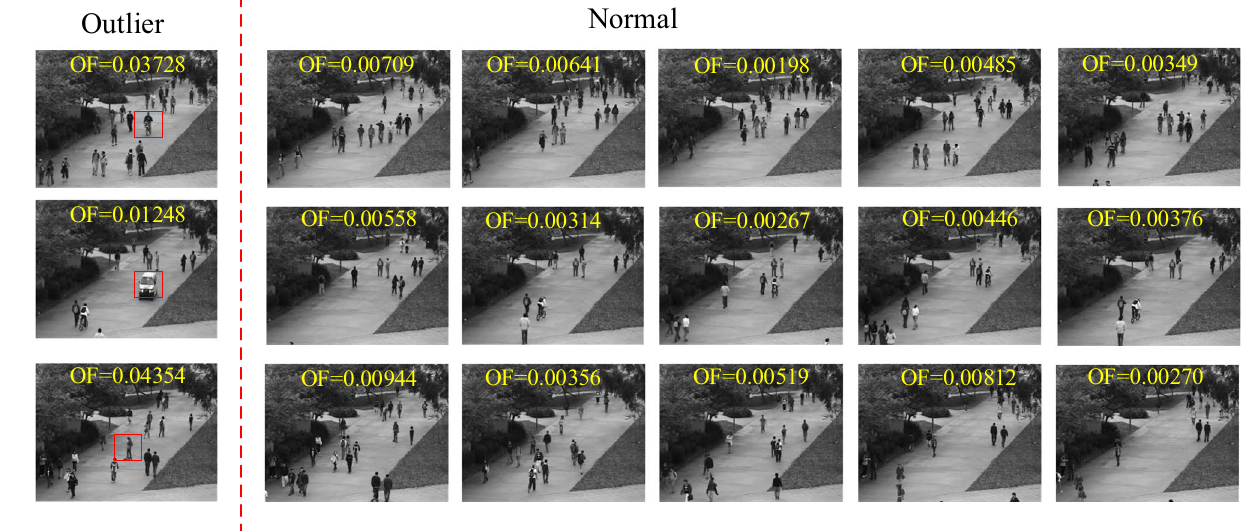
Figure 10. Visualization of FBOD detection results. The OF value of the leftmost outlier is significantly higher than that of the normal